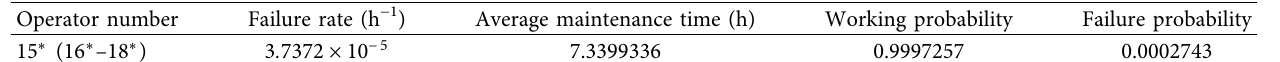
Table 4: Reliability parameters of operators 11 ∗ (12 ∗ –14 ∗ ).